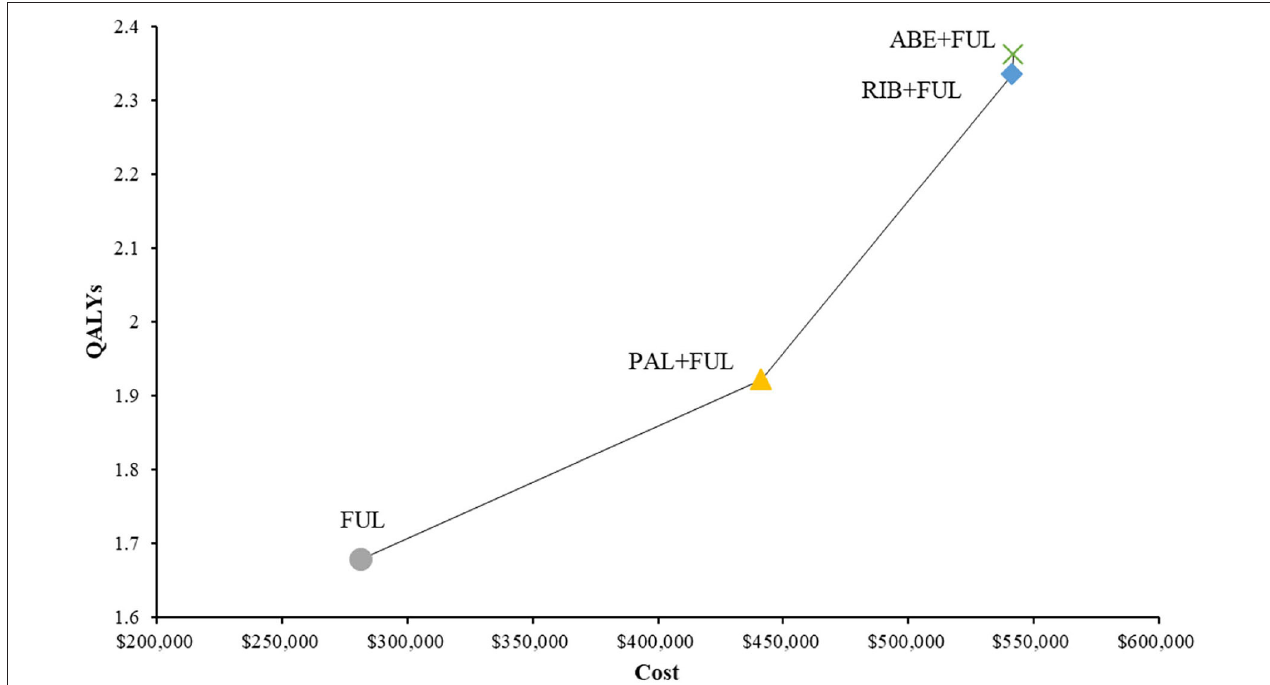
FIGURE 4 | Cost-effectiveness plane of different treatment options. QALYs, quality-adjusted life years; ABE, abemaciclib; RIB, ribociclib; PAL, palbociclib; FUL, fulvestrant.